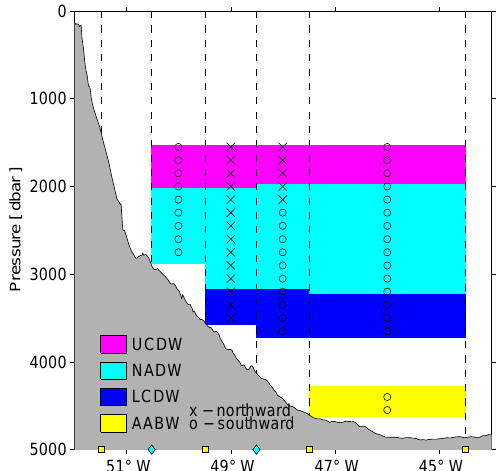
Figure 4. Schematic section illustrating the observed deep wa- ter masses and their time-mean flow direction across the section. Water-mass definitions are as noted in the text, with the direction of flow denoted with either an “x” or an “o” as noted. Time mean is determined over the December 2012–October 2014 time period when all six PIES/CPIES sites are available. Water masses are deter- mined using the PIES + GEM estimated profiles. Note the dissolved oxygen criteria for UCDW cannot be tested using the PIES + GEM data, so only the neutral density criteria were employed here; evalu- ation using the CTD section data suggests that the oxygen criteria is consistently met in the depth range where the UCDW neutral den- sity criteria are